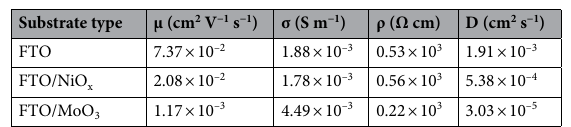
Table 5. Electrical parameters of the CISe films with various